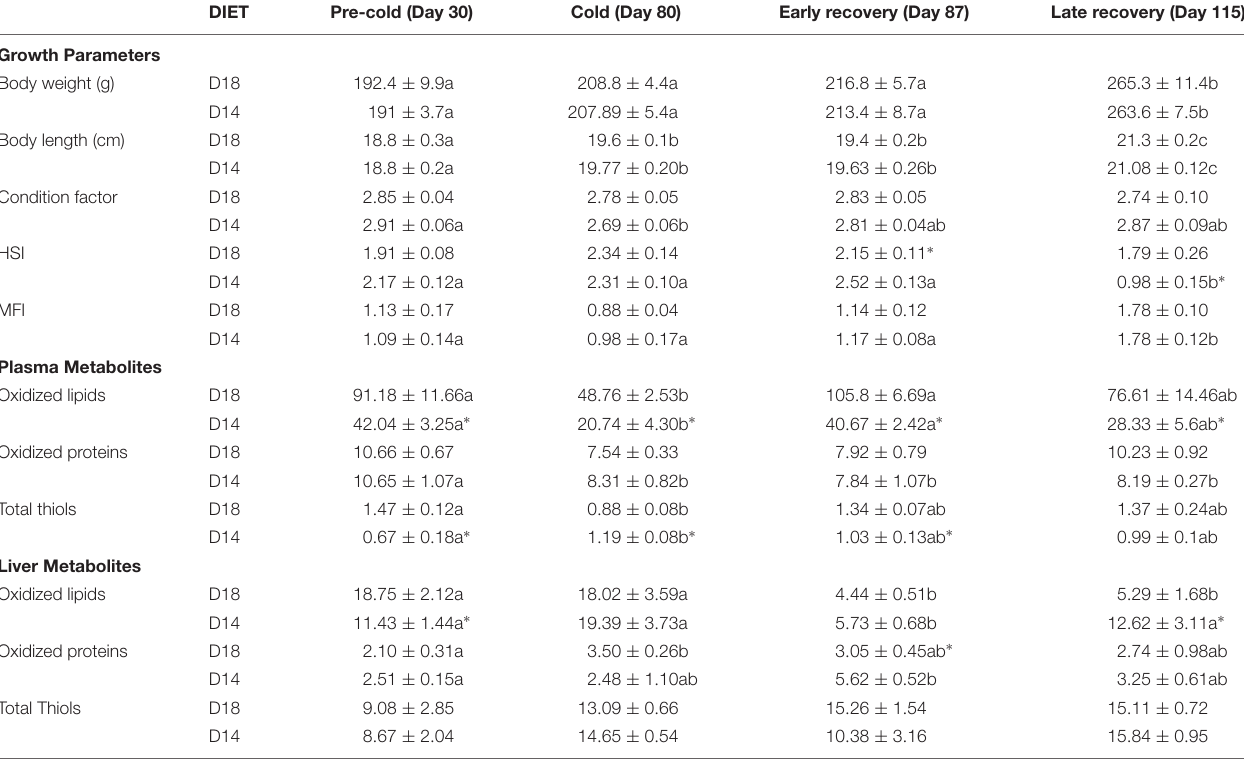
TABLE 2 | Growth performance and redox-related metabolites in plasma and liver of gilthead sea bream throughout temperature fluctuation. DIET Pre-cold (Day 30) Cold (Day